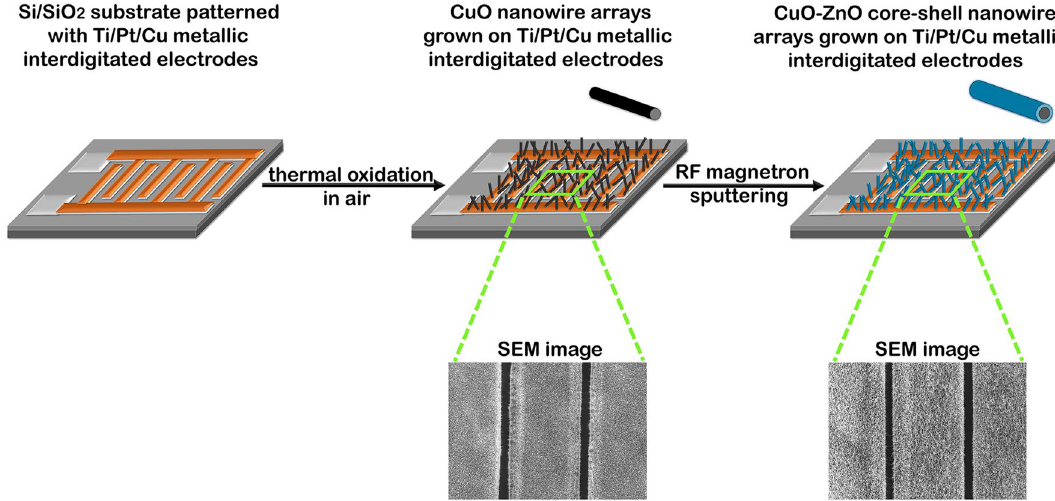
Figure 2. Schematic representation of the main steps involved in the development of the photodetector system based on self-connected CuO–ZnO core–shell heterojunction nanowire arrays grown on metallic interdigitated